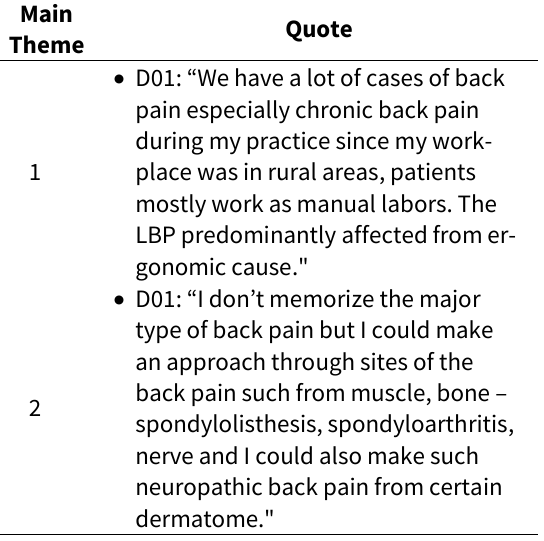
Table 3 . Synthesis of GP Knowledge toward SpA by